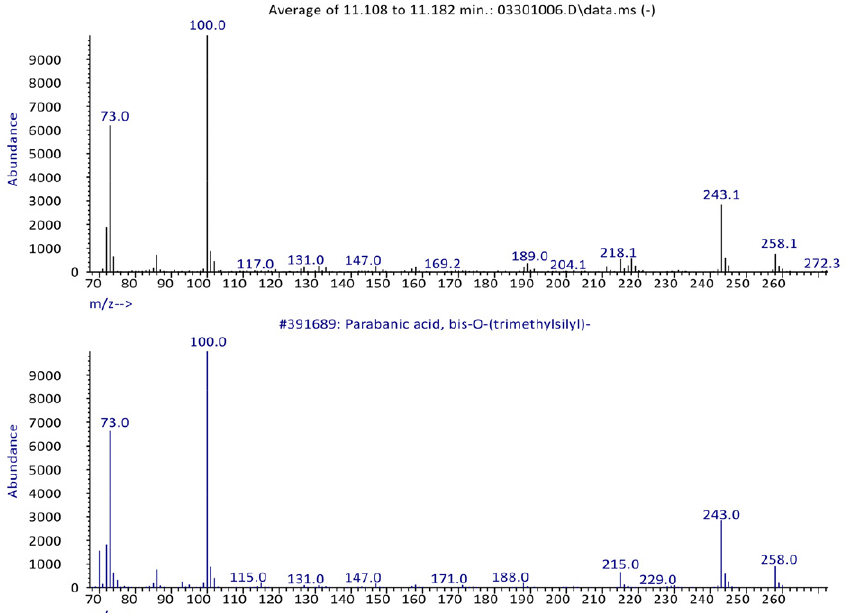
Figure 7. Mass spectrum comparison of imidazolidine-2,4,5-trione 2TMS derivative (parabanic acid 2TMS) in sample 03 and Willey-NIST library mass spectral Vončina: Marker Compounds Adsorbed on Dust Particles ...